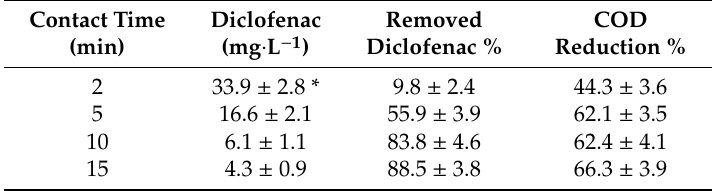
Table 3. Treatment with ultraviolet (UV)